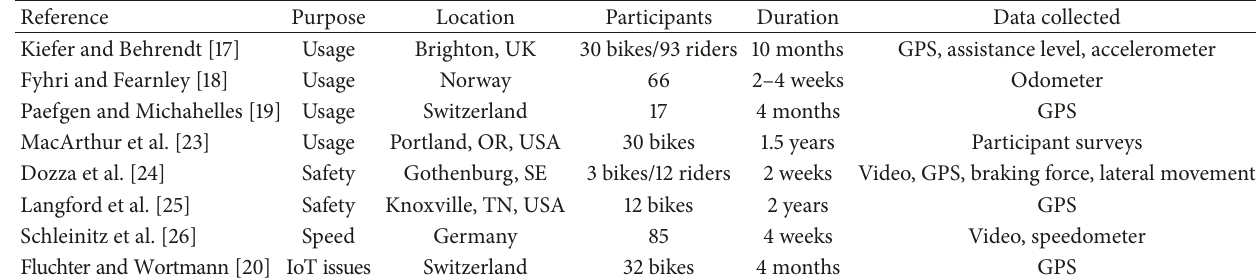
Table 1: Summary of previous e-bike field